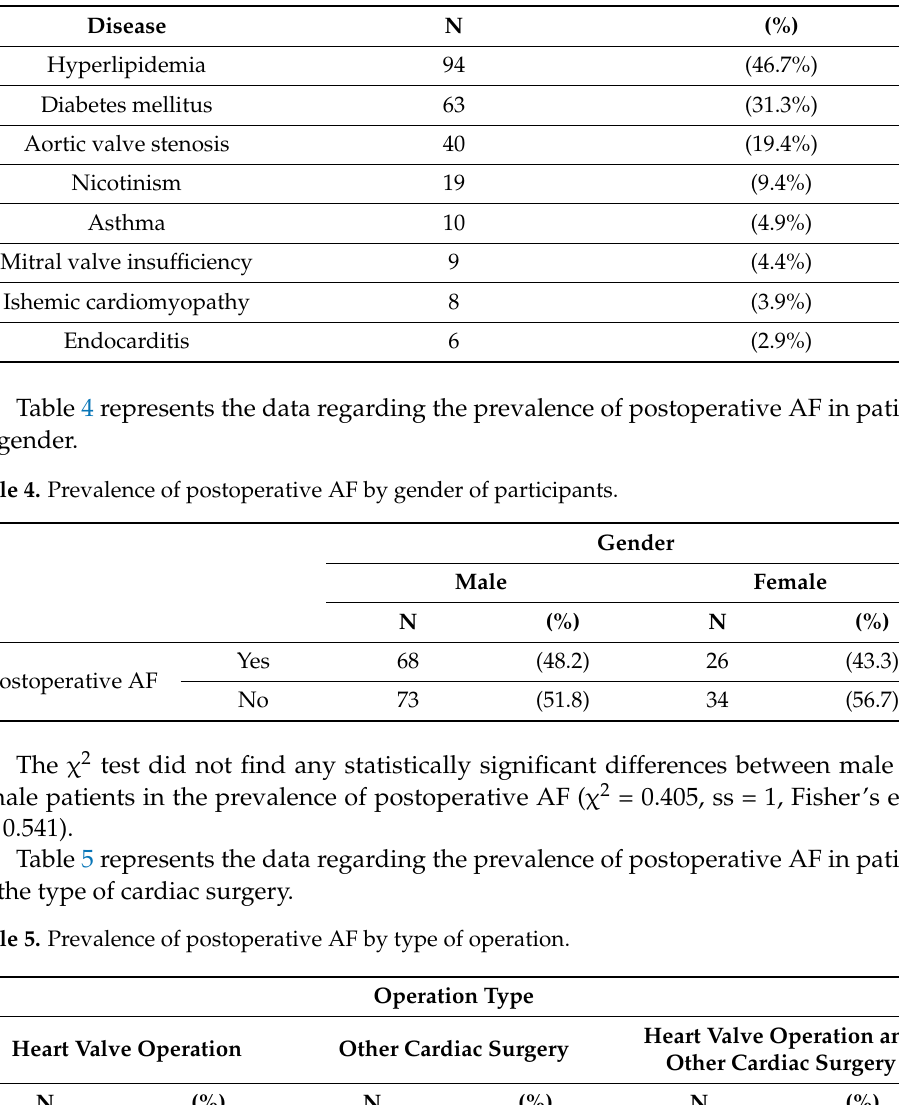
Table 3. Prevalence of other diseases besides arterial hypertension, coronary heart disease, and rheumatic heart disease.